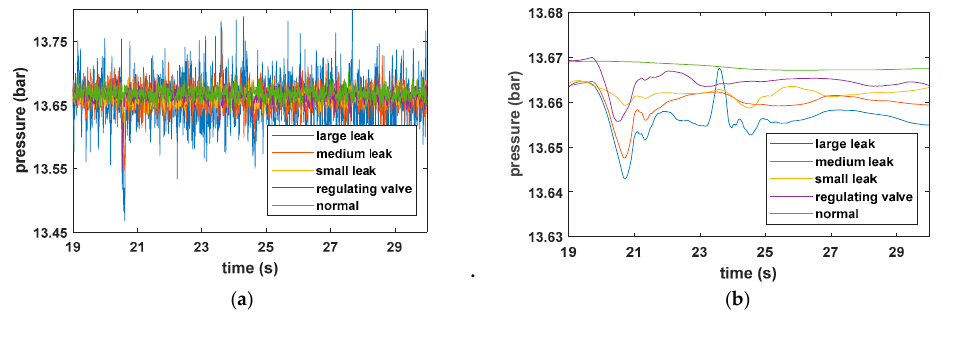
Figure 4. Pressure signals before and after noise reduction. ( a ) Original data samples. ( b ) Reconstructed signals. Table 2. An example of time-domain features and waveform-domain features under different operating modes and leak scenarios.